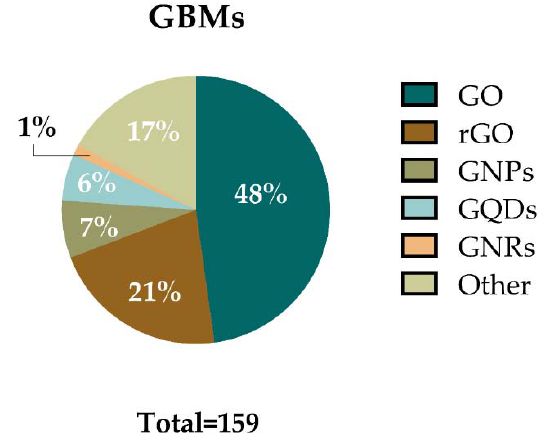
Figure 5. Percentages of the in vitro, in vivo and biomonitoring assays carried out using different GBMs (graphene oxide, GO; reduced GO, rGO; graphene nanoplatelets, GNPs; graphene quantum dots, GQDs; graphene nanoribbons, GNRs; and others).